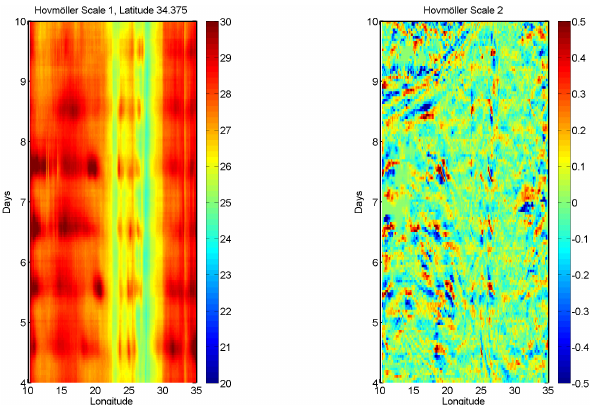
Figure 7. Hovmöller diagram in the eastern Mediterranean at lati- tude 34.375 ◦ N. Temperature as a function of longitude (in degrees) and time (in days) for process 1 (left panel) and process 2 (right